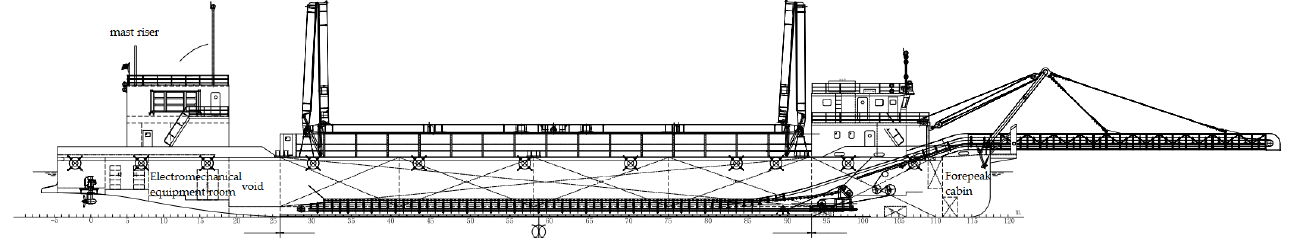
Figure 1. The general layout of a hydrogen powered ship.